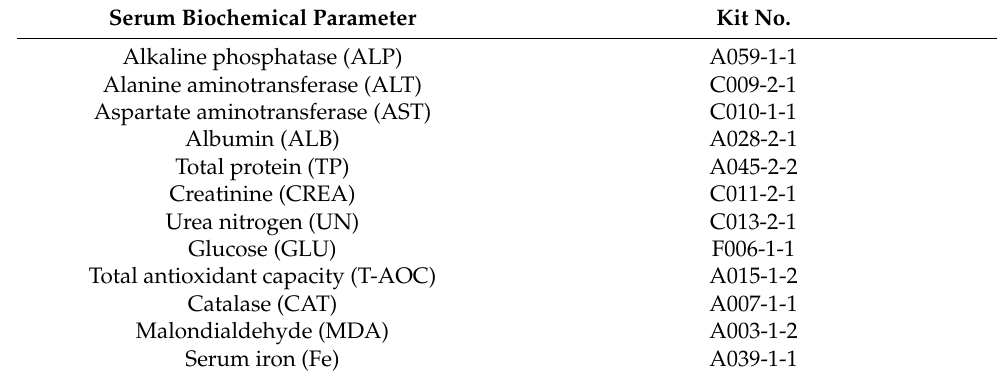
Table 2. The serum biochemical parameters with the corresponding commercial kit number. Serum Biochemical Parameter Kit No.